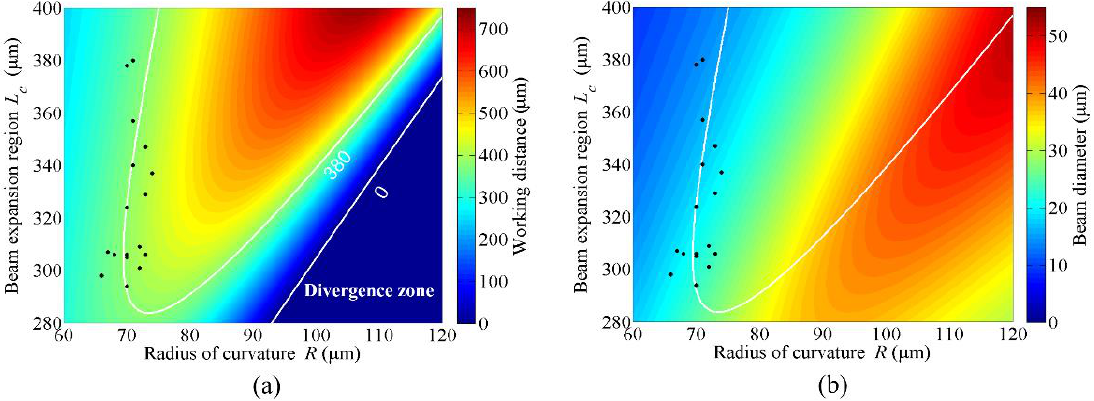
Figure 7. Working distances ( a ) and beam diameters ( b ) of LOF probes numerically calculated as a function of parameters L c and R by using the Gaussian ABCD matrix method. The black dots represent the measured parameters of fabricated 17 LOFs. The white contour represents the combination of parameters giving the same working distance of 380 μm.